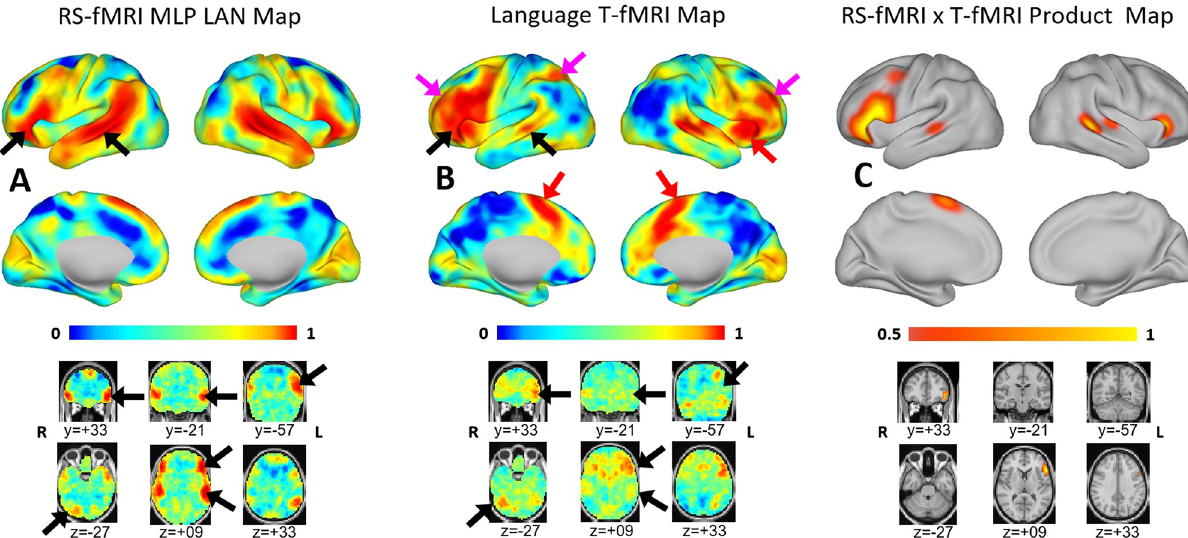
Fig 1. Mean language maps. Mean resting-state functional MRI and task-based functional MRI language maps displayed on the PALS B-12 inflated surface (top) and in volumetric representations with the MNI152 atlas as underlay (bottom). Note common intensity scale spanning the interval [0, 1] (see Methods (Statistical Analysis) for details concerning scale equalization). Each voxel is assigned a value in the range [0, 1] to express the likelihood of belonging to the language network. (A) Mean language map derived by MLP analysis of resting-state functional MRI data. (B) Mean task-based functional MRI response to word generation. (C) Responses common to task-based functional MRI and resting-state functional MRI computed as the product of the values shown in panels A and B, thresholded at 0.7. Black arrows point to parts of the brain specific to language function, which include, besides areas of Broca and Wernicke, the right inferior cerebellum. Red arrows point to task responses in the salience network; magenta arrows point to left intra-parietal sulcus and regions in the middle frontal gyrus bilaterally which are components of the dorsal attention network. The salience and dorsal attention networks are not specific to